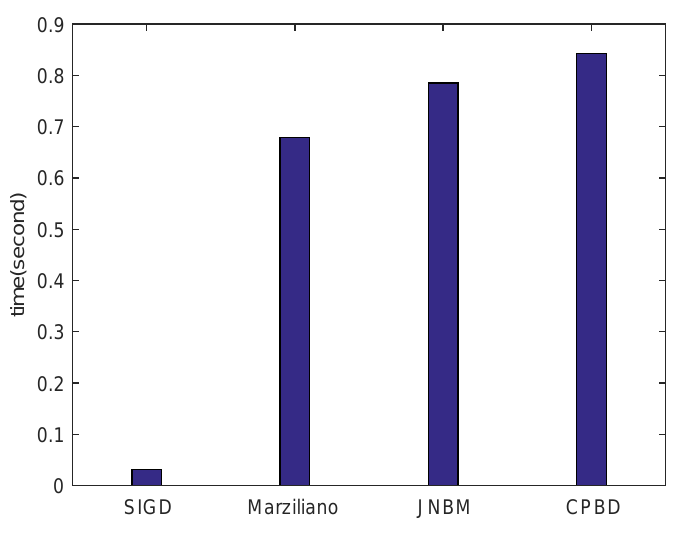
Figure 6. Average computation time for each method.